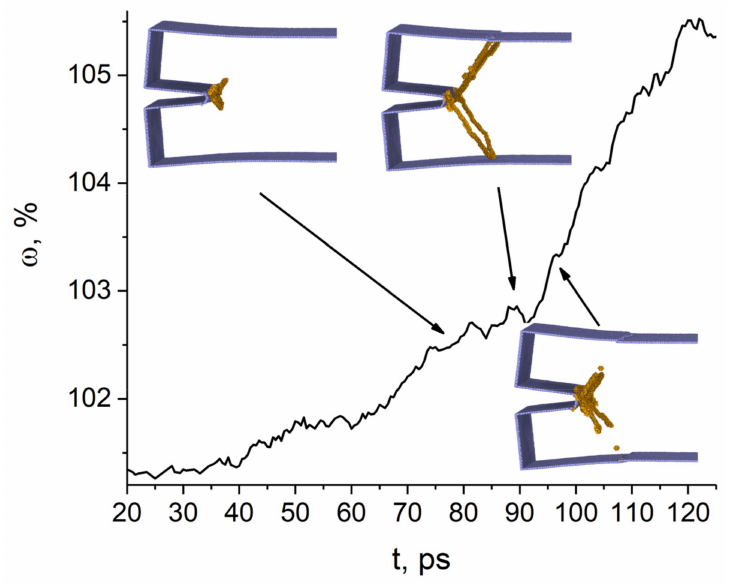
Figure 2. Time variation of atomic volume at the tip of the (011)[011] crack. Surface atoms are colored blue, dislocations are colored orange. Atoms with bcc nearest neighbor symmetry are not